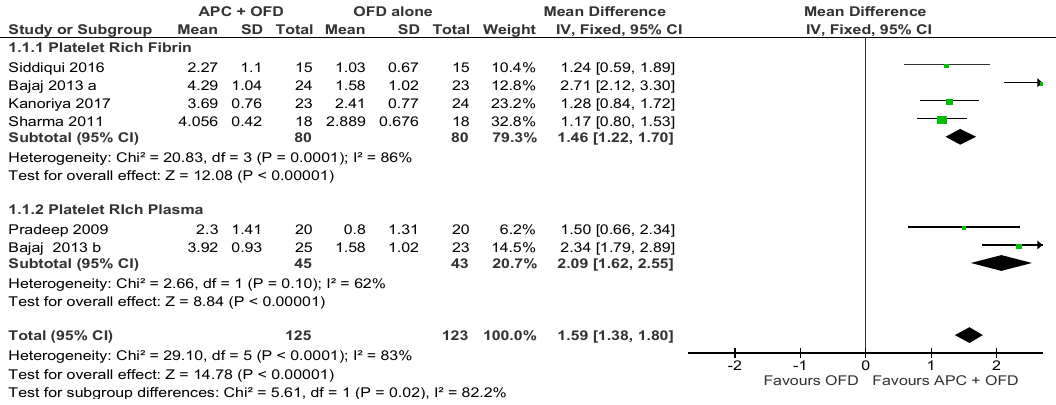
Figure 3. Forest plot showing the effect on probing pocket depth for comparison of APC + OFD versus OFD alone at end of all-follow-up (6–12 m).